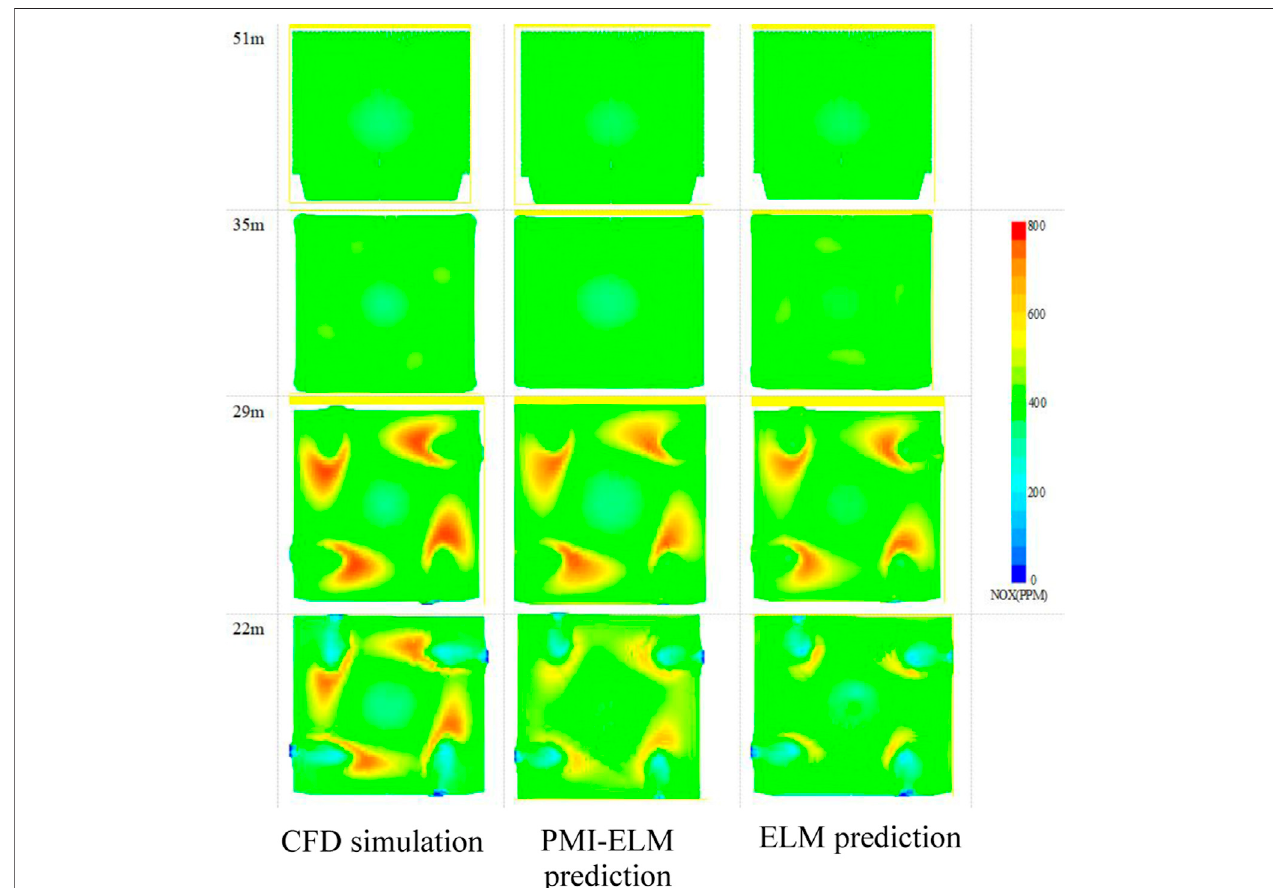
FIGURE 6 | Contours of NO X concentration along the height of the furnace obtained from different methods.